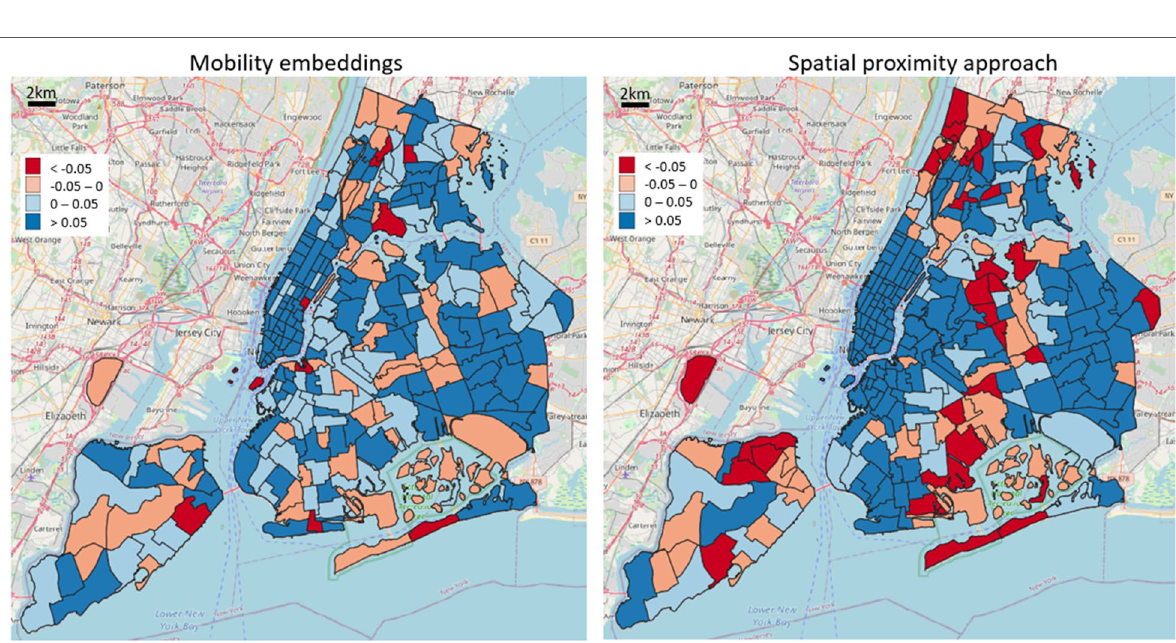
Fig. 9 Assessment of functionality cluster consistency according to different dining-related POI classes (fast food, restaurant, pub, café): cosine similarity difference between intra- and extra-cluster averages for each reference